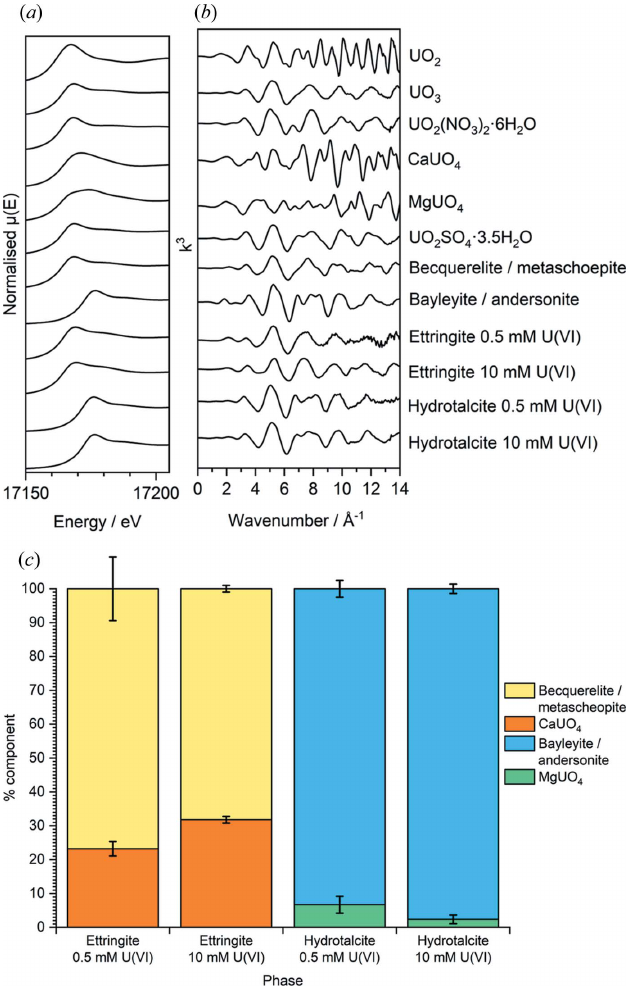
Figure 5 U L III -edge energy spectra of all U VI -contacted phases and mineral standards, showing ( a ) the XANES region (normalized and offset for clarity); ( b ) the corresponding k 3 -weighted EXAFS spectra (offset for clarity); and ( c ) a bar graph highlighting the percentage component of signals contributing to the linear combination fit of each system (graphical fits are given in the supporting